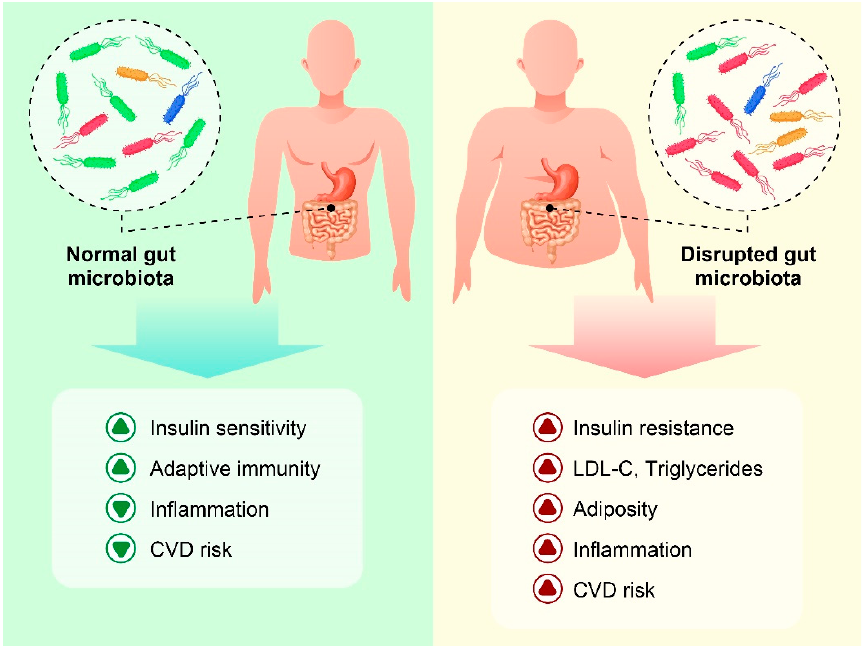
Figure 1. Normal gut microbiota and maintenance of proper metabolic function in healthy individuals ( left ). The role of dysbiosis in the progression of some metabolic disorders in obese individuals ( right ).